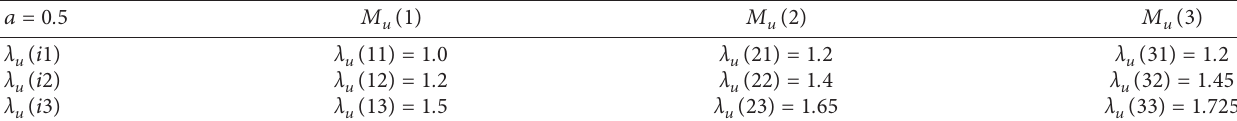
( i ) for a � 0 . 5, unit: 1/year. u